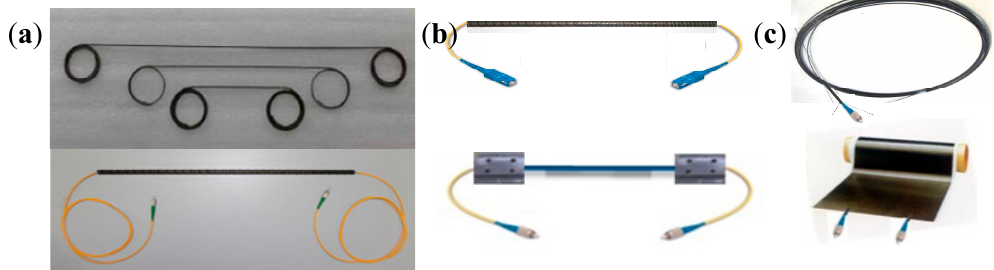
Figure 5. Gauge sensors: ( a ) long gauge optical fiber sensors; ( b ) embedded anchorage and fixed anchorage (from top to bottom); ( c ) self-sensing cable and self-sensing cloth.